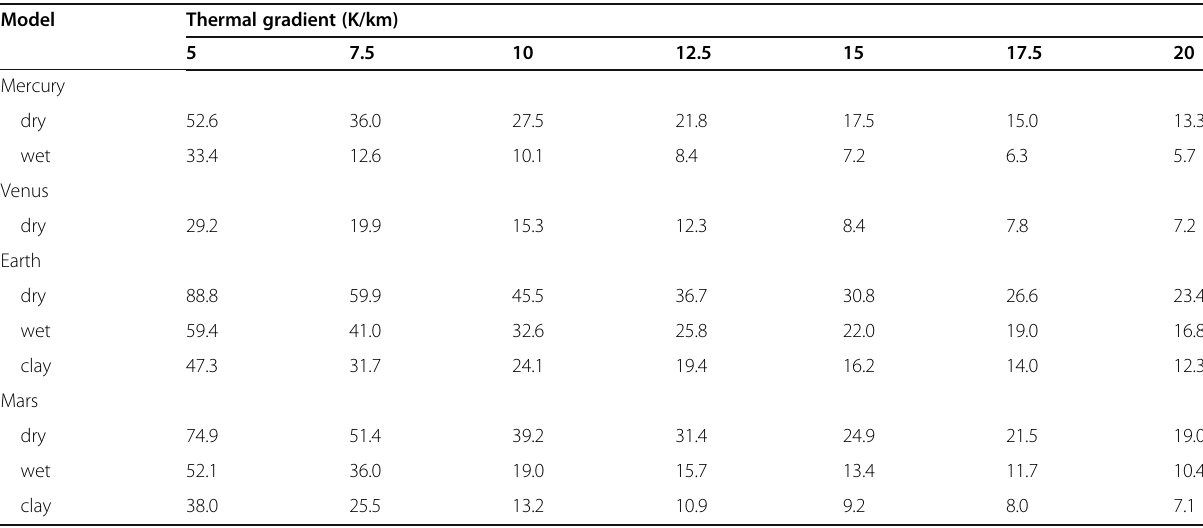
Table 3 Elastic thickness (km) calculated using strain-rate of 10 -17 s -1